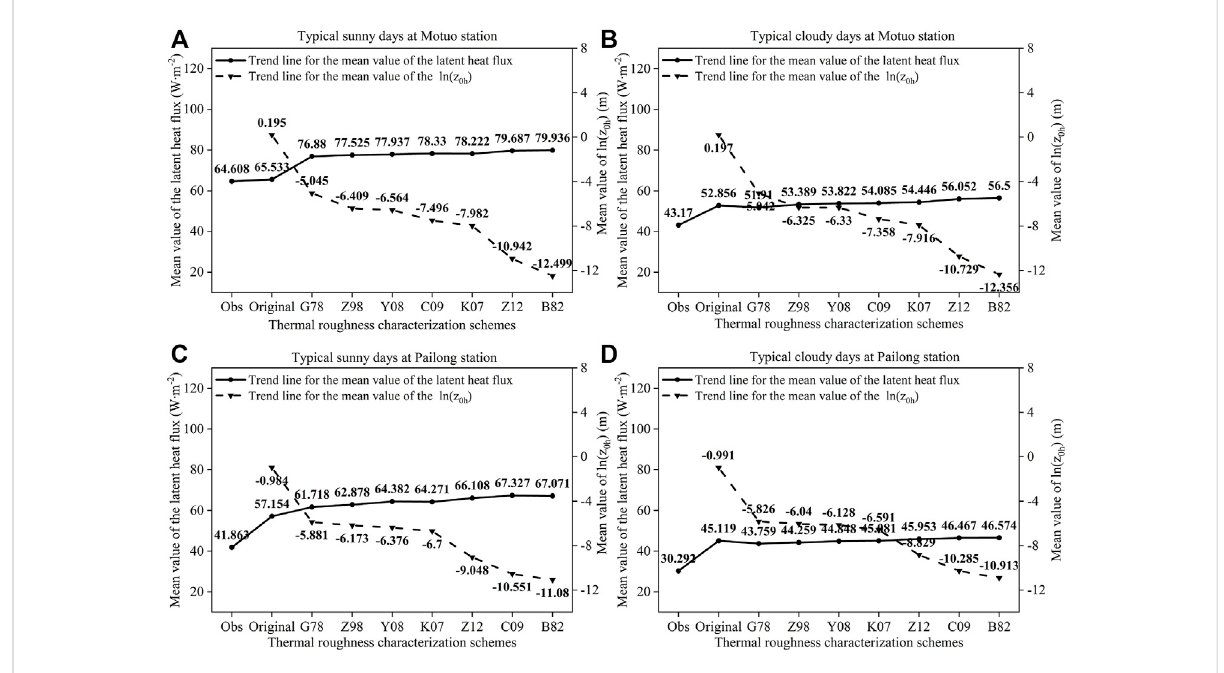
FIGURE 13 Comparison of the Simulations of LE and Z 0h under different Z 0h schemes on typical sunny/cloudy days at Motuo and Pailong